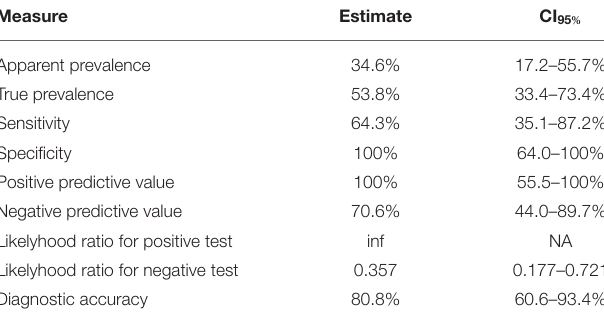
TABLE 2 | Measures of diagnostic test accuracy.